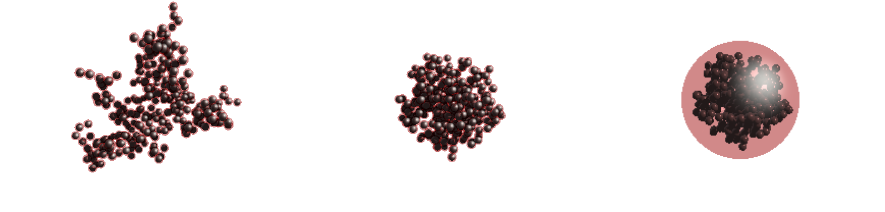
Figure 1. BC models, n s = 300, k 0 =